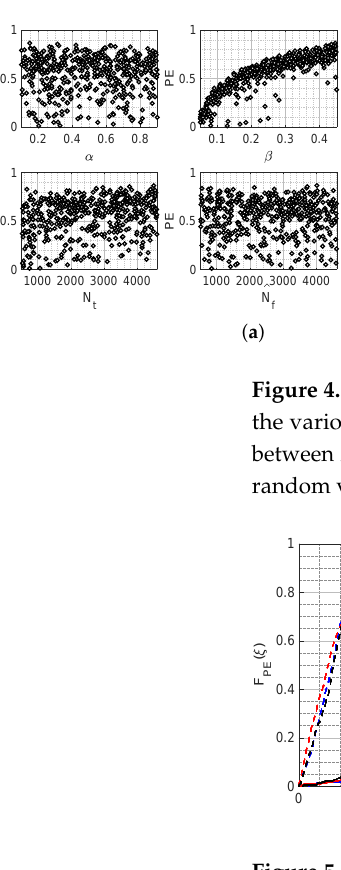
Figure 5. Cumulative distribution functions of the percentage error related to the three sharpening